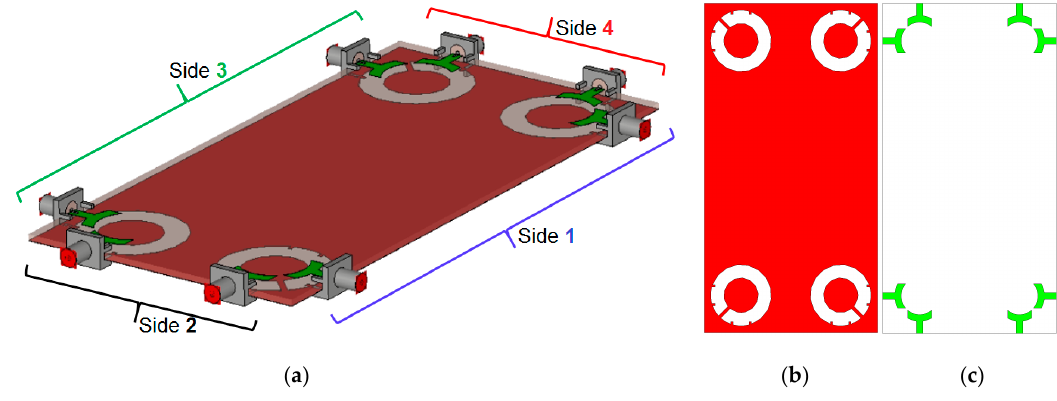
Figure 16. ( a ) Side, ( b ) top, and ( c ) bottom views of the UWB-multiple-input / multiple-output (UWB-MIMO) antenna system design for smartphone applications.